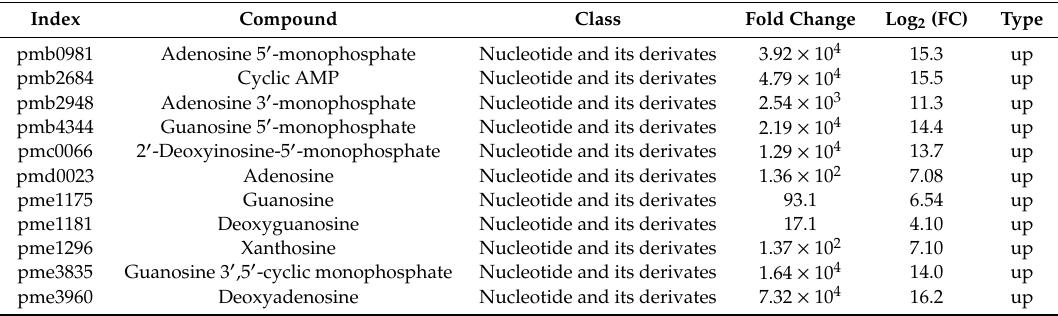
Table 2. DAMs involved in purine metabolism during embryogenic di ff erentiation (PEC vs. NEC).